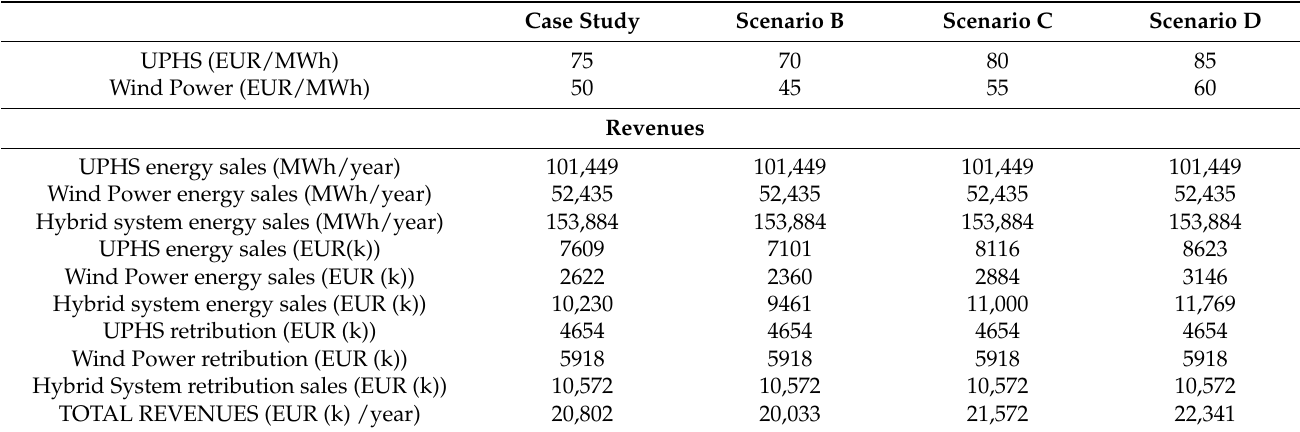
Table 5. Sensitivity analysis. Total annual energy sales revenues for different